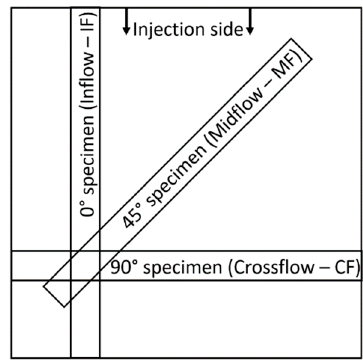
Figure 3. Positions of the 0° (IF), 45° (MF) and 90° (CF) orientated bending specimens.